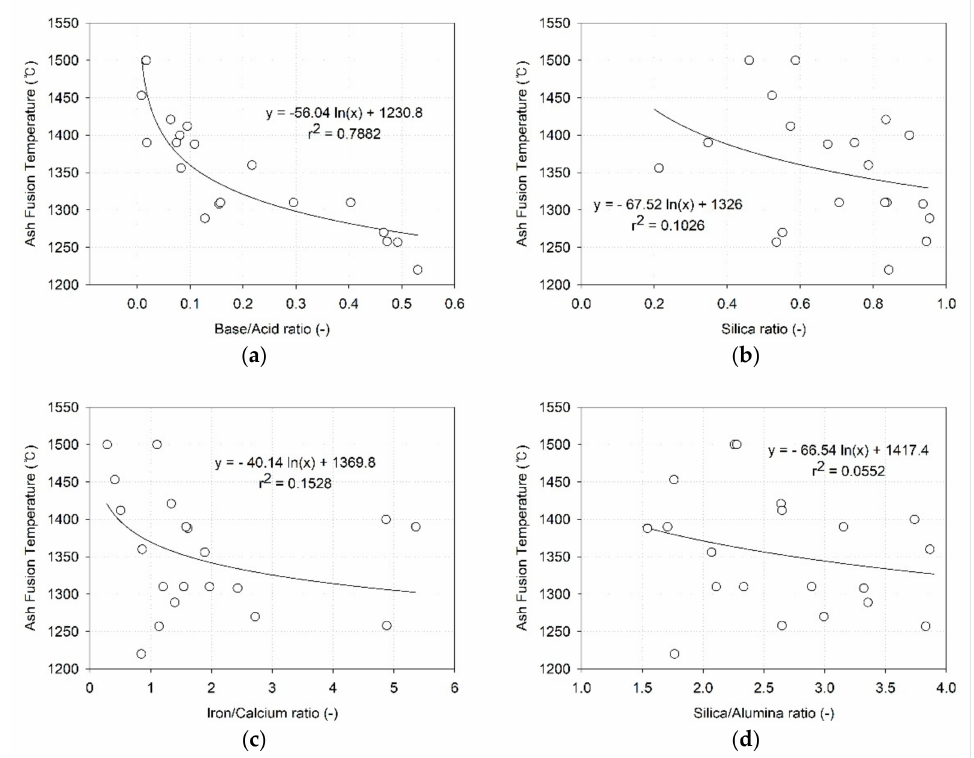
Figure 7. Correlation of coal melting indices: ( a ) base/acid ratio, ( b ) silica ratio, ( c ) iron/calcium ratio, ( d ) silica/alumina